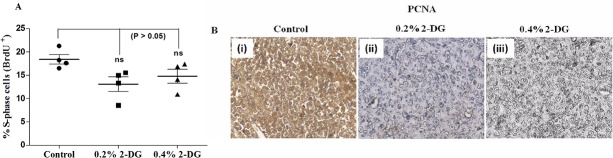
Effect of dietary 2-DG on tumor cell proliferation in EAC tumor model.(A) BrdU positive (proliferating) cells analyzed by flow cytometry. S-phase cells in tumors of 2-DG fed mice were numerically reduced, although the differences were not statistically significant (One-way ANOVA), (B) Immuno-histochemical staining of PCNA in tumors; (i) Control, (ii) 0.2% 2-DG and (iii) 0.4% 2-DG. Tumors from 2-DG treated animals exhibited reduced PCNA staining in comparison to control group animals.